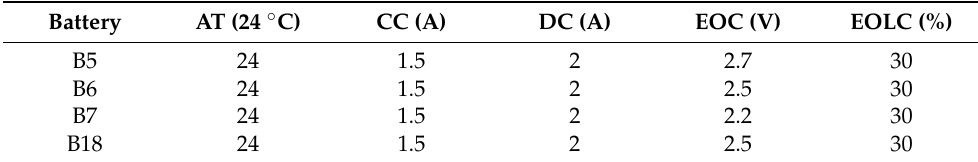
Table 1. Parameter setups of battery #5, #6, #7 and #18.